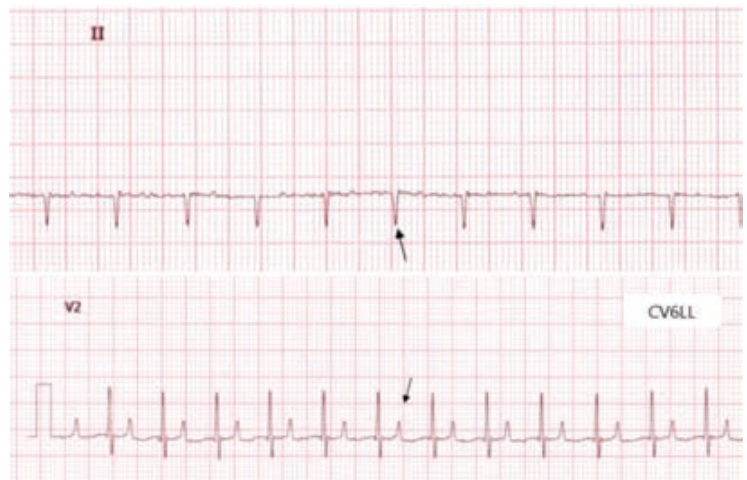
Fig. 4. ECG of animal number S1, showing QS pattern in lead II (arrow), Peaked T wave in precordial lead CV6LL (arrow) (Paper speed – 25